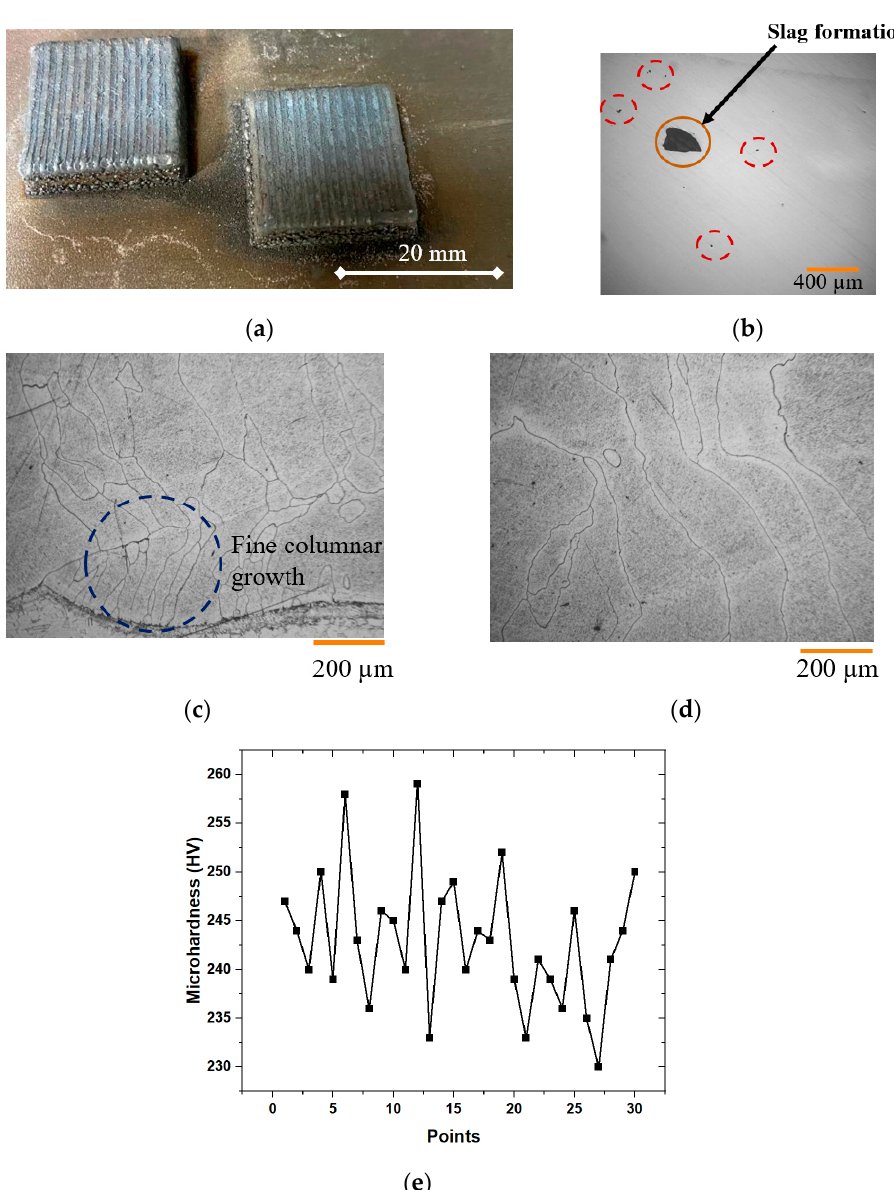
Figure 15. Multi-layer structures. ( a ) Photographic view; ( b ) Cross-section image; ( c ) Microstructure at the interface; ( d ) Microstructure at top layers; ( e ) Microhardness measurements.